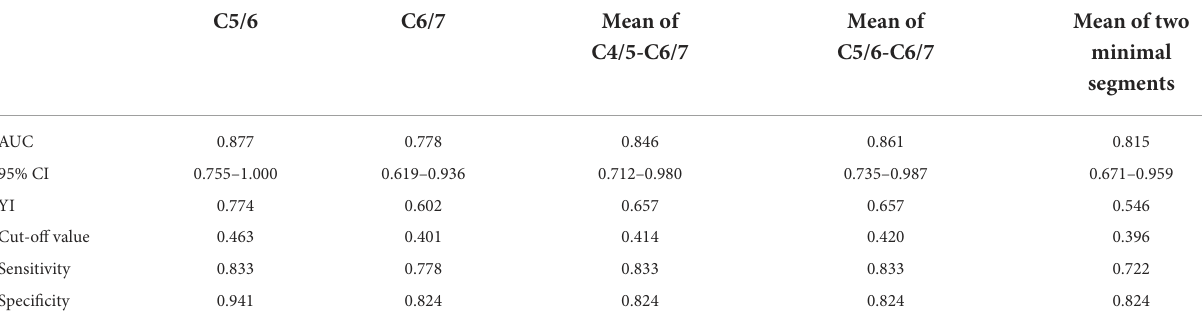
TABLE 6 Parameters derived from ROC analysis according to flexion FA value.